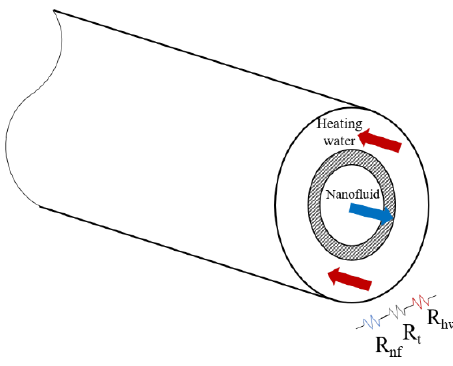
Figure 1. Thermal resistances in the tube-in-tube heat